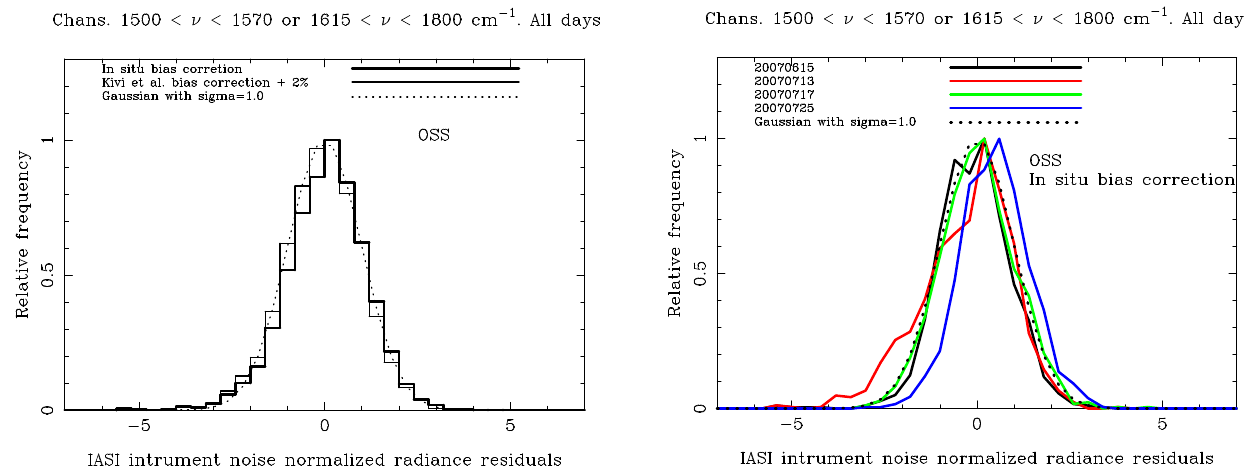
Fig. 12. Histogram of the residual radiances, IASI observed mi- nus calculated with OSS RTM and time interpolated profiles, for all clear days (4) in the spectral range, 1500cm − 1 ≤ ν ≤ 1570cm − 1 and 1615cm − 1 ≤ ν ≤ 1800cm − 1 . One set of interpolated profiles have been derived from the CFH sonde launched 1h before IASI overpass and the “in situ” bias corrected RS92 sonde launched 5min before satellite overpass (thick solid line). The other set of interpo- lated profiles have been derived from the CFH sonde launched 1h before IASI overpass and the Kivi et al. + 2% bias corrected RS92 sonde launched 5min before satellite overpass (thin solid line). For reference, a Gaussian curve with a σ of 1.0 is shown (dotted line).